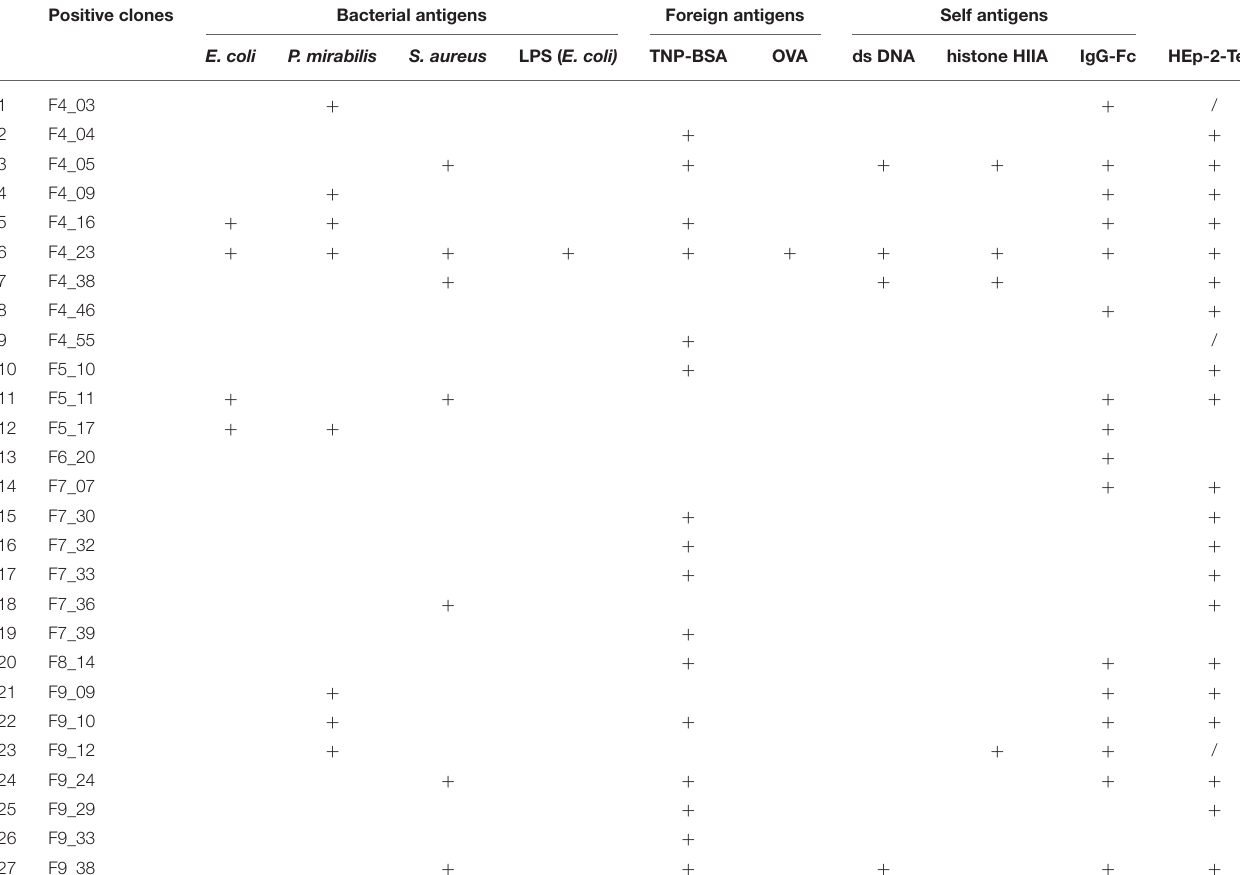
TABLE 3 | Antigen-binding patterns of positively-tested IgM hybridomas. Positive clones Bacterial antigens Foreign antigens Self